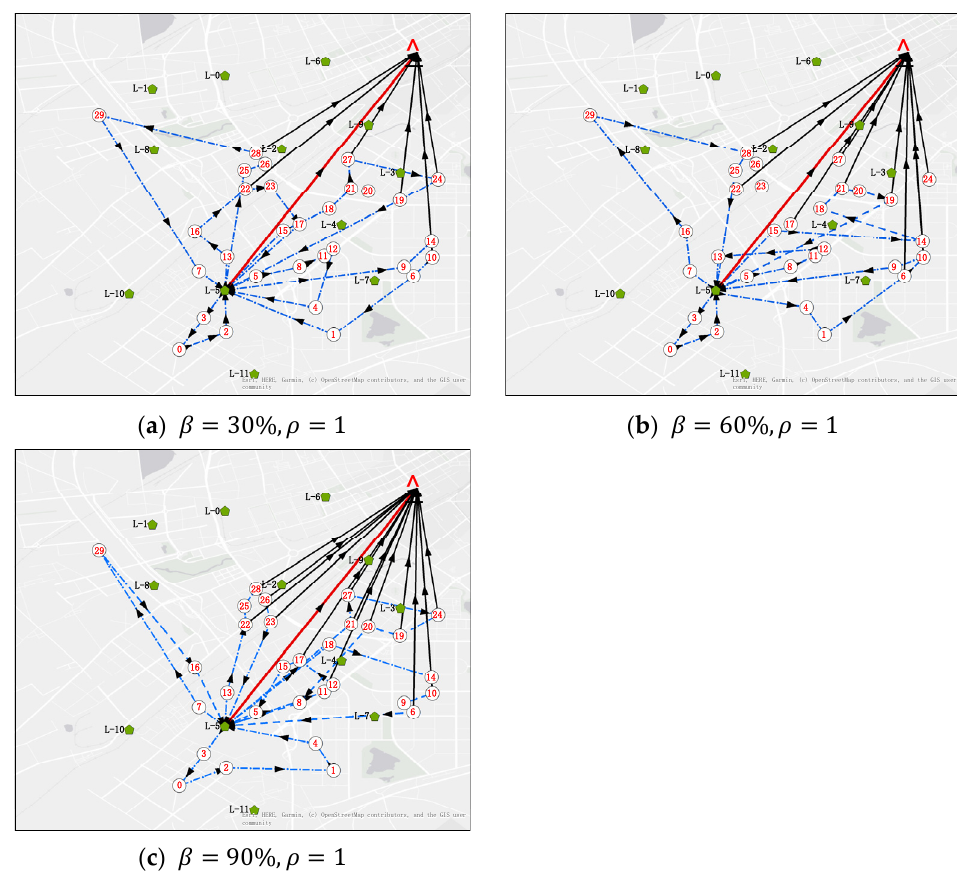
Figure 10. The impact of uncertainty level on the delivery routing decisions.